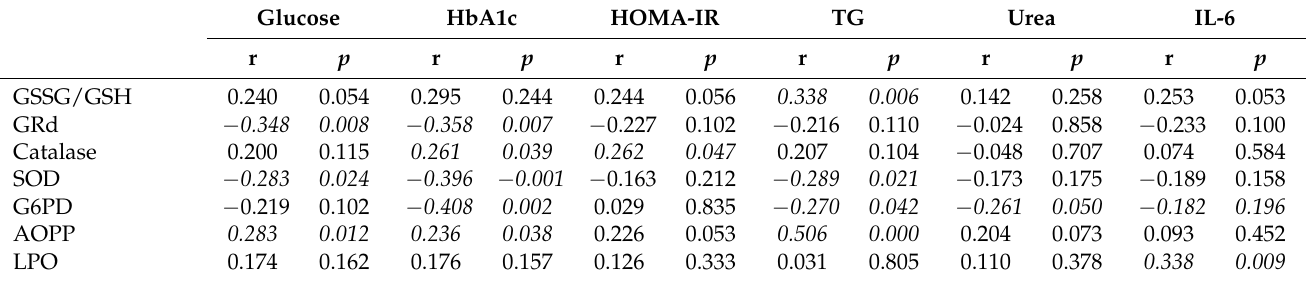
Table 3. Summary of significant ( p < 0.05) Pearson correlations between oxidative stress markers and biochemical variables for all participants.